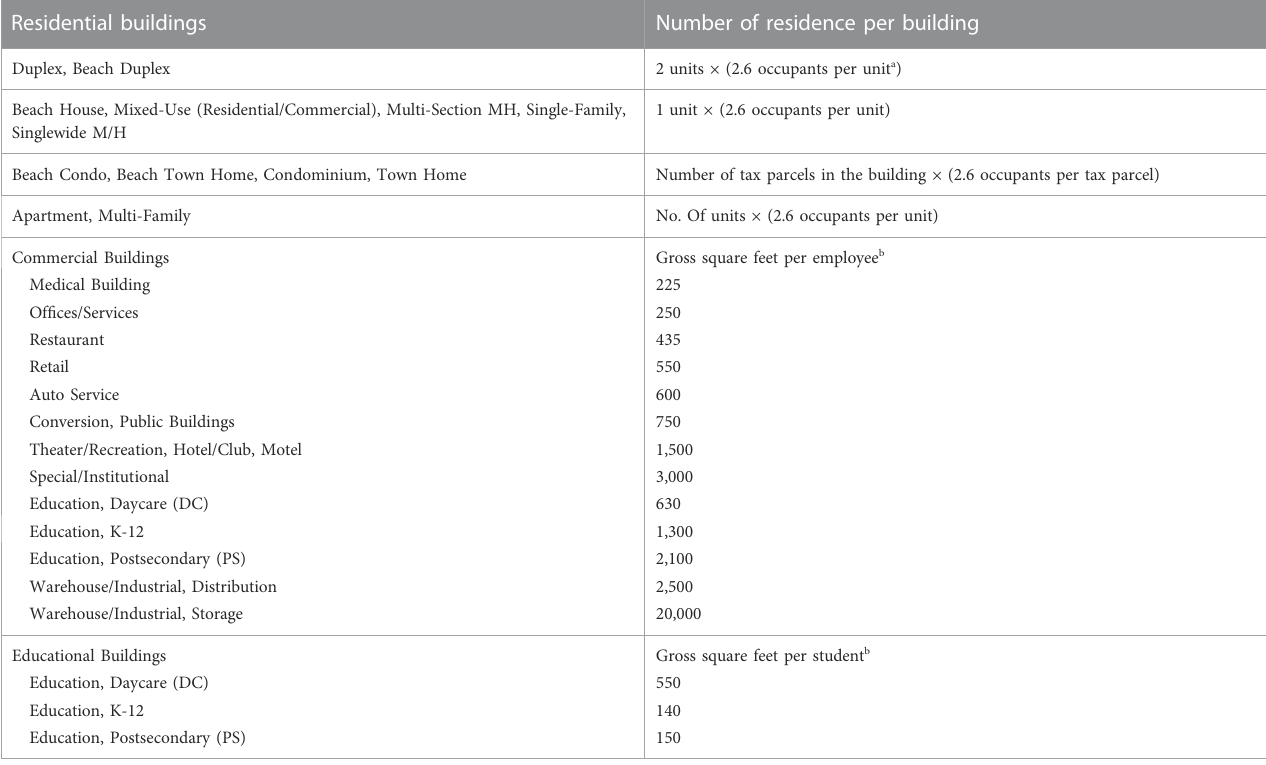
TABLE 1 Occupancy